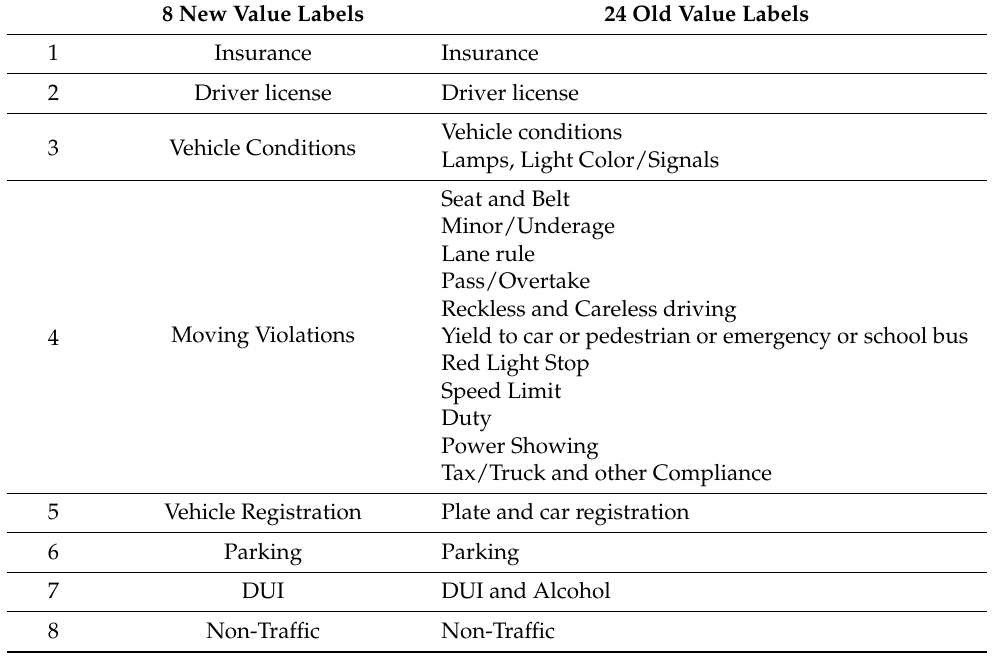
Table A2. 24 new charge categories grouped by charge type into 8